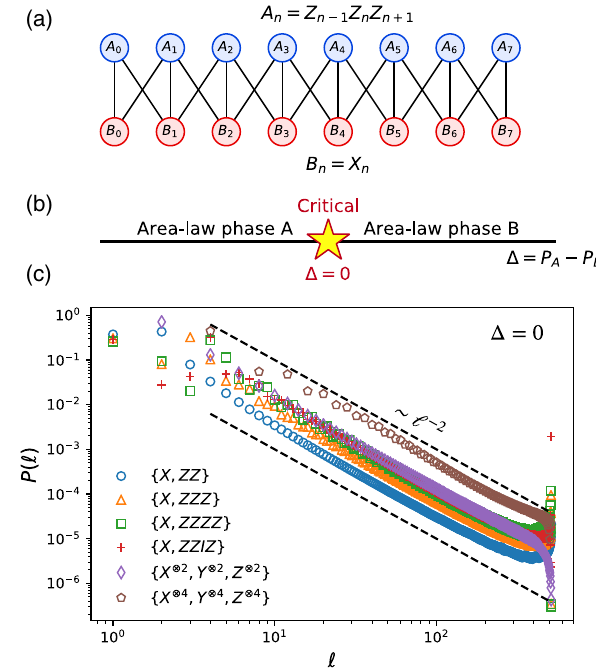
FIG. 6. (a) Example of a frustration graph for a bipartite ensemble, f X; ZZZ g . Vertices represent operators, and edges represent anticommutation. (b) General phase diagram of 1D − P bipartite ensembles: As a function of Δ ¼ P , there are two A B area-law phases separated by a self-dual critical point at Δ ¼ 0 . (c) Probability distribution of stabilizer length P ð l Þ in several bipartite ensembles at the Δ ¼ 0 critical point in a system of L ¼ 512 qubits (data aggregated from 10 3 runs for each ensem- ble). A power-law tail P ð l Þ ∼ l − 2 , corresponding to logarithmic entanglement, is seen in all